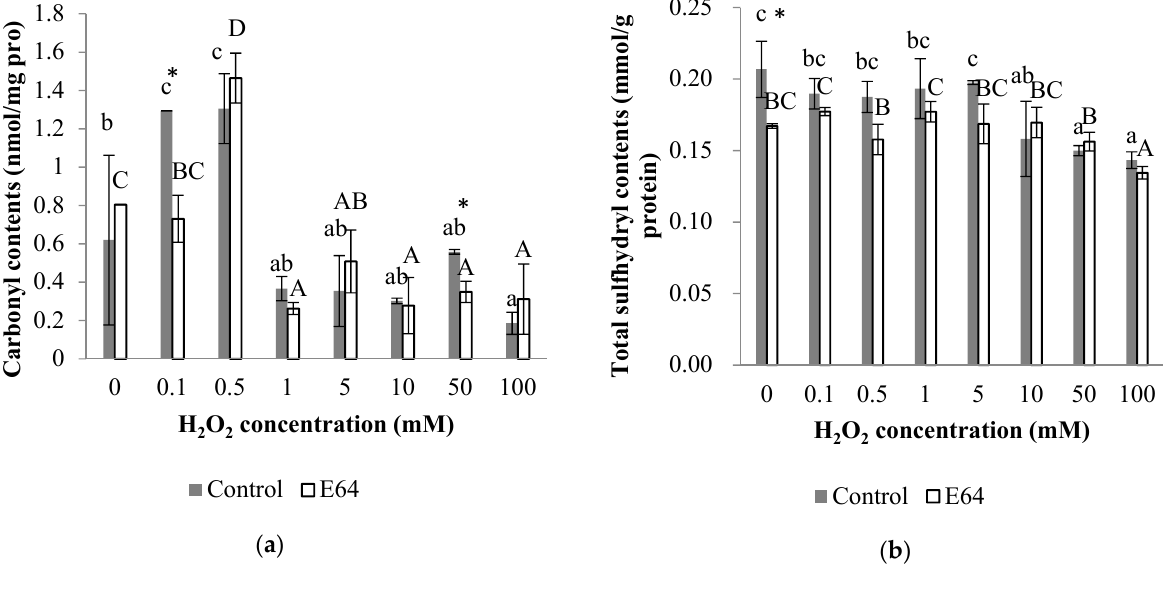
Figure 3. Changes of carbonyl contents ( a ) and total sulfhydryl contents ( b ) of myofibrillar protein from bighead carps under different H 2 O 2 concentrations. The same lowercase letter indicates no significant differences between samples of control group under different H 2 O 2 concentrations. The same capital letter indicates no significant differences between samples of E64 group under different H 2 O 2 concentrations. The asterisk indicates significant difference between samples in control and E64 groups under the same H 2 O 2 concentration ( p < 0.05).